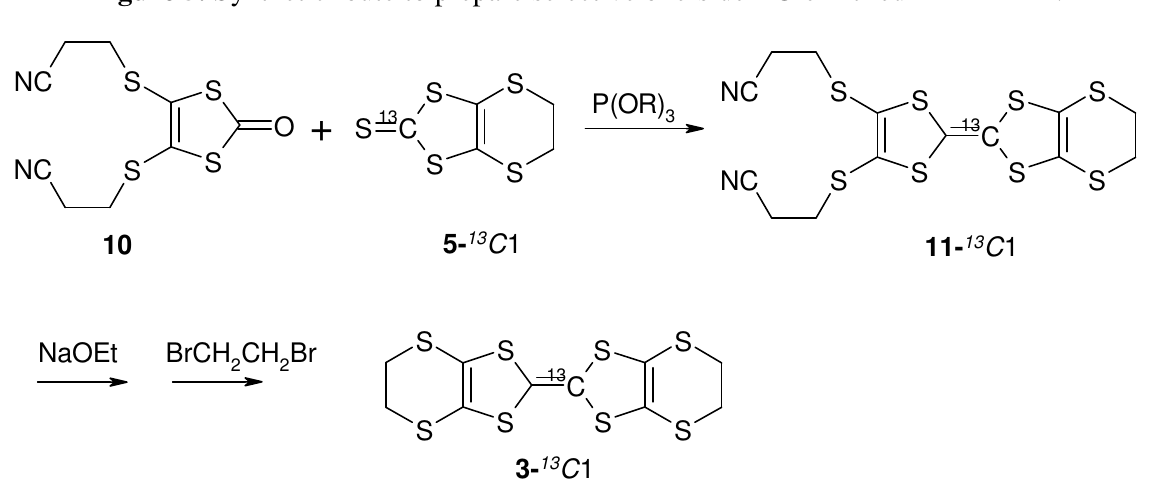
Figure 5. Synthetic route to prepare selective one-side 13 C-enriched